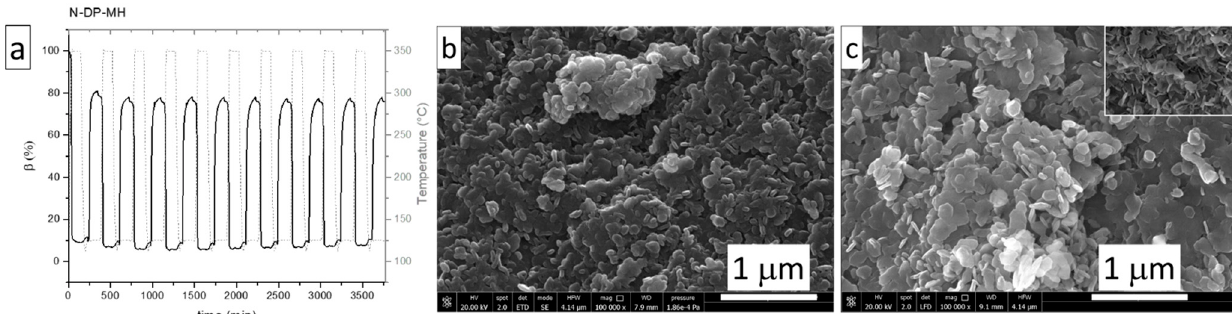
Figure 8. ( a , c ) Stored and ( b , d ) released heat per mass unit and volume unit at the 3rd cycle.